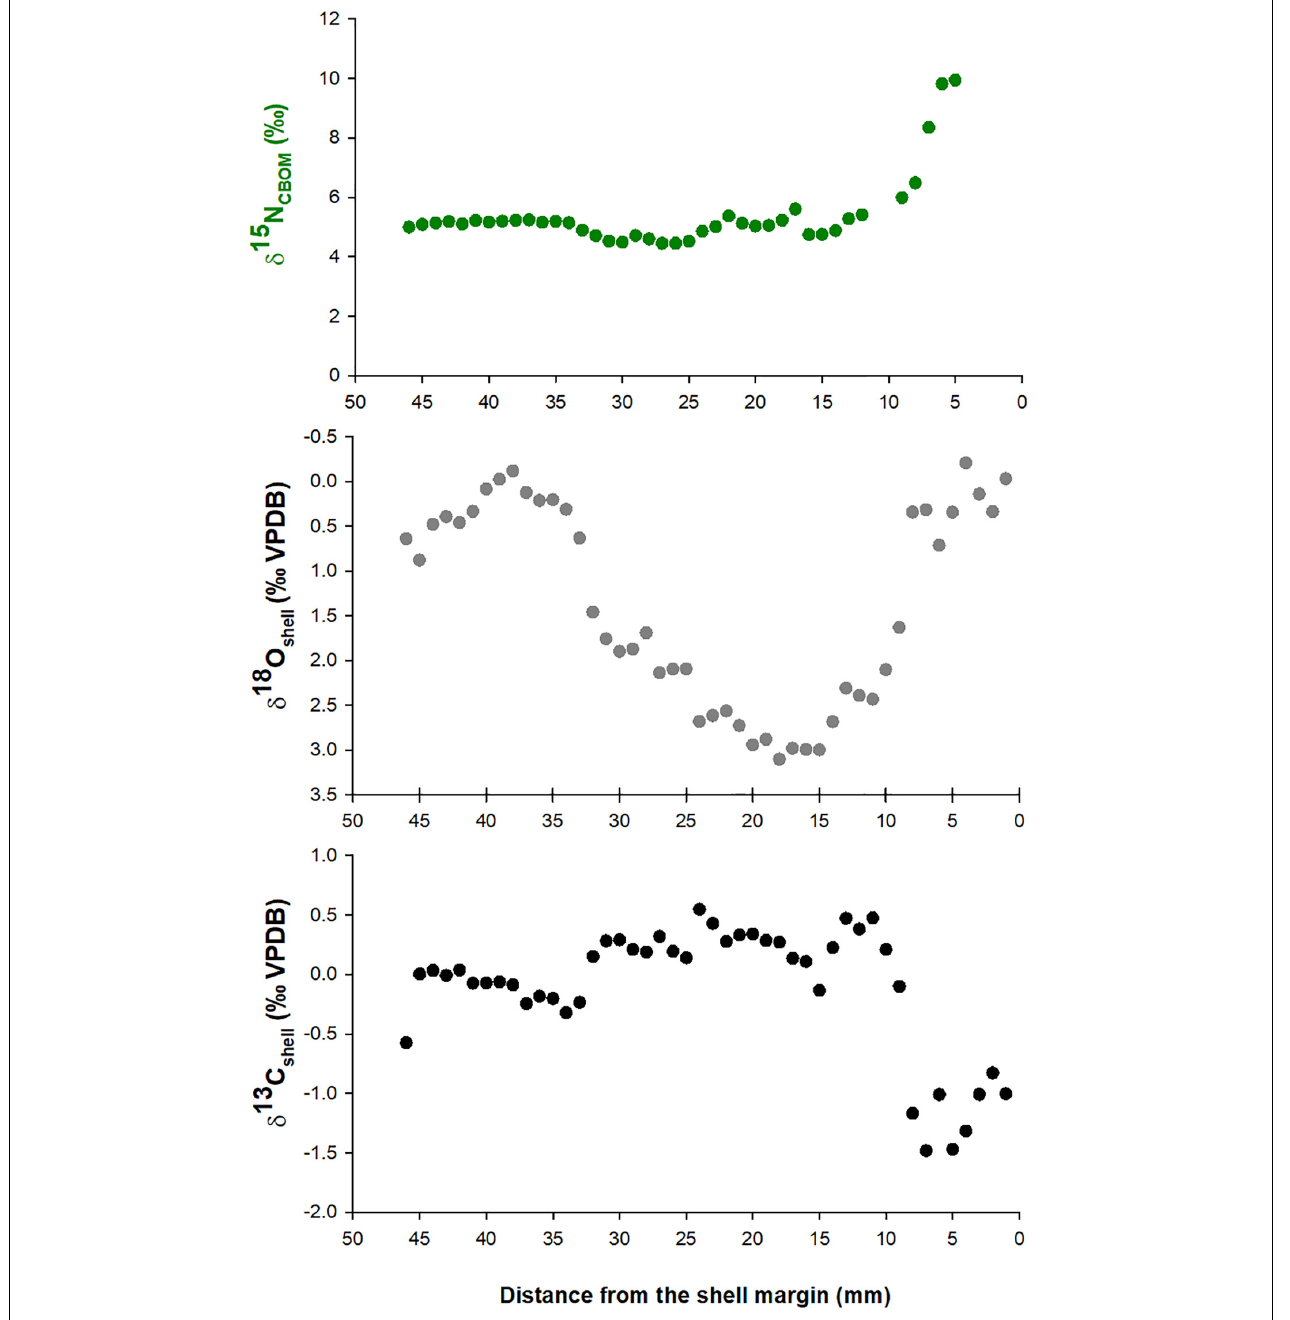
( Figure 3 ). Similar site-specific δ 15 N CBOM differences existed in samples from the external shell surface of the specimens collected from three